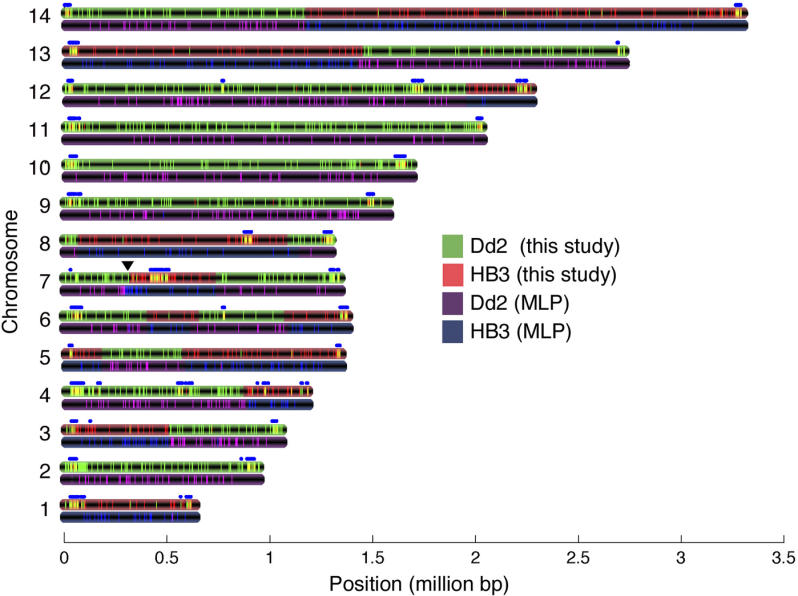
Mapping the Recombination Breakpoints across the 14 P. falciparum Chromosomes in the Chloroquine-Sensitive F1 Progeny Strain C188A total of 14,289 SFPs were identified over three hybridizations by comparing HB3, Dd2, or the recombinant line C188 to 3D7. SFPs were recorded as HB3 (green bars) in the recombinant line if the probe was scored as polymorphic in both C188 and HB3 but not Dd2, or were recorded as Dd2 (red bars) if scored as polymorphic in Dd2 and C188 [19] but not HB3. Regions with a large number of markers scored as both HB3 and Dd2 are shown in yellow and are associated with the known locations of var, rifin, and stevor genes (shown as blue dots). Markers determined by microsatellite length mapping (MLP) are coloured purple and blue [7].